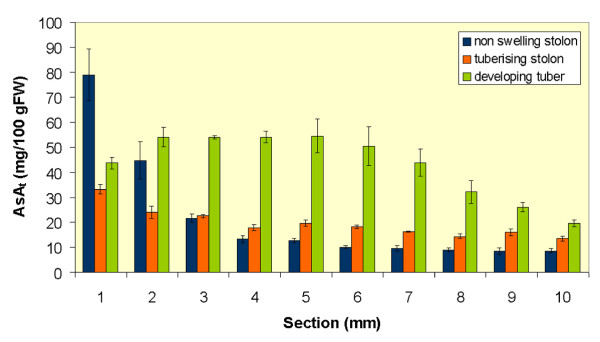
Distribution of AsAt along the axes of stolons and developing tubers. Non-swelling stolons, tuberising stolons or developing tubers were excised from glasshouse grown plants and sliced into 1 mm transverse sections which were quickly weighed and immediately frozen in liquid nitrogen. Samples were ground to a powder, extracted in 5% MPA, 5 mM TCEP (9:1 v/w) and AsAt in the extract supernatant estimated by HPLC. Values are represented as mean ± SE, n = 3.